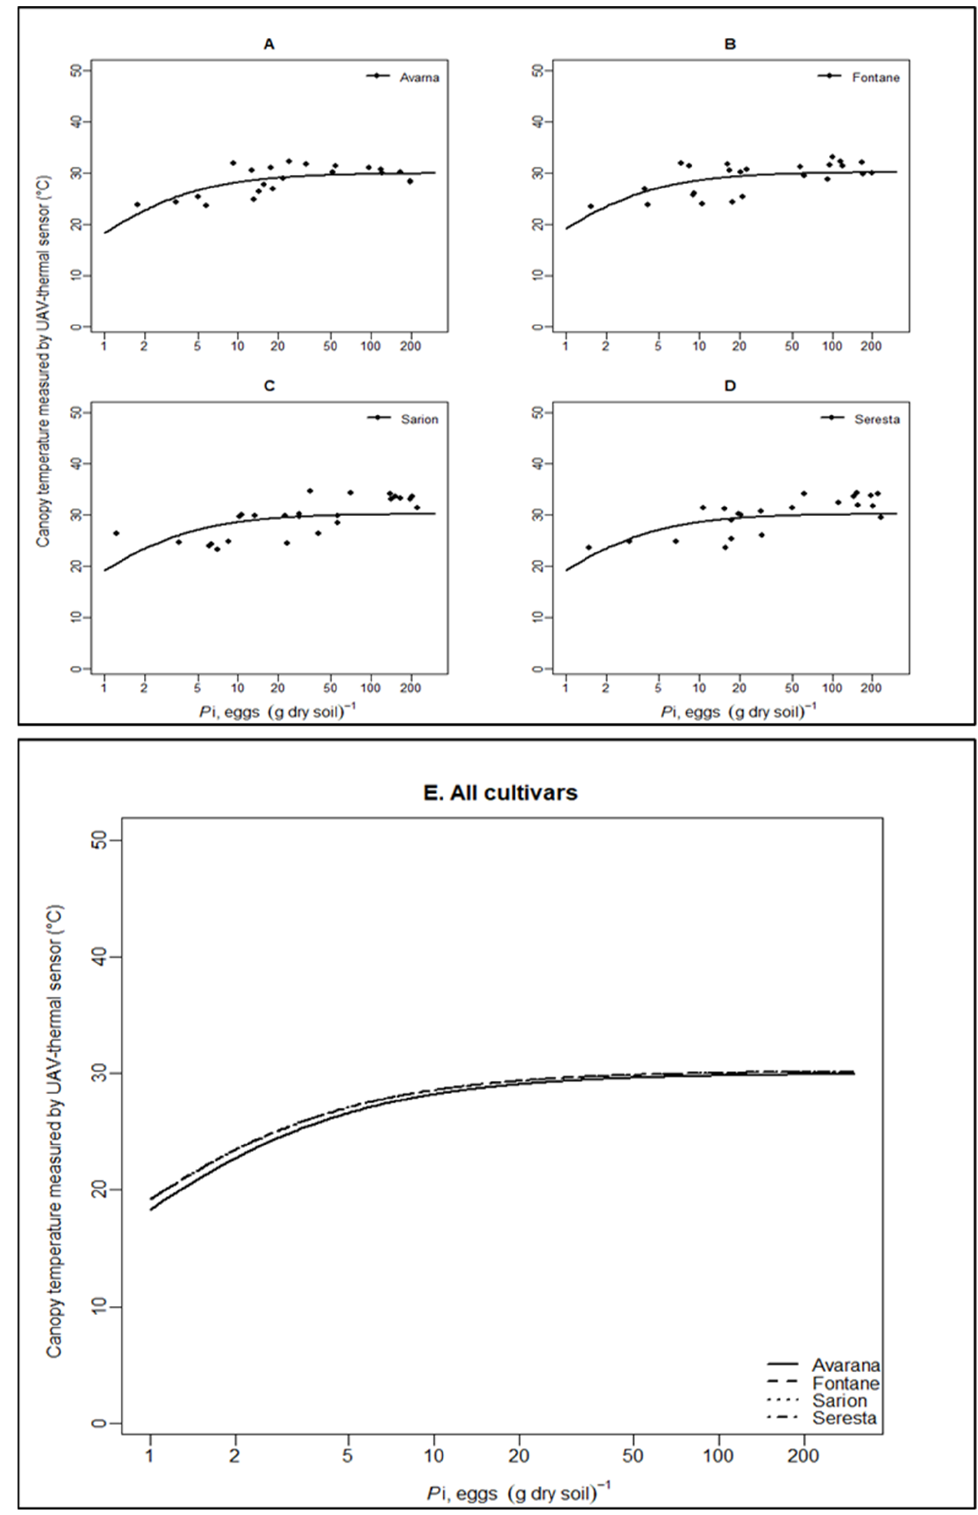
Figure 4. Relationship between the initial population P i, eggs (g dry soil) − 1 of potato cyst nematodes in a potato field and canopy temperature (°C) of potato as measured by the thermal sensor of unmanned vehicle (UAV), according to Equation (6). ( A ) Avarna. ( B ) Fontane. ( C ) Sarion. ( D ) Serresta. ( E ) All cultivars.